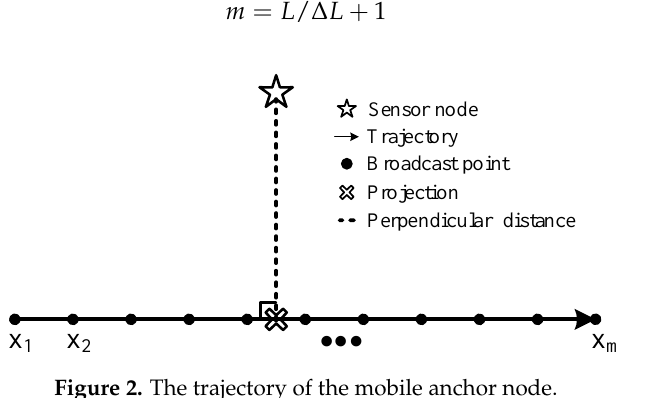
Figure 2. The trajectory of the mobile anchor